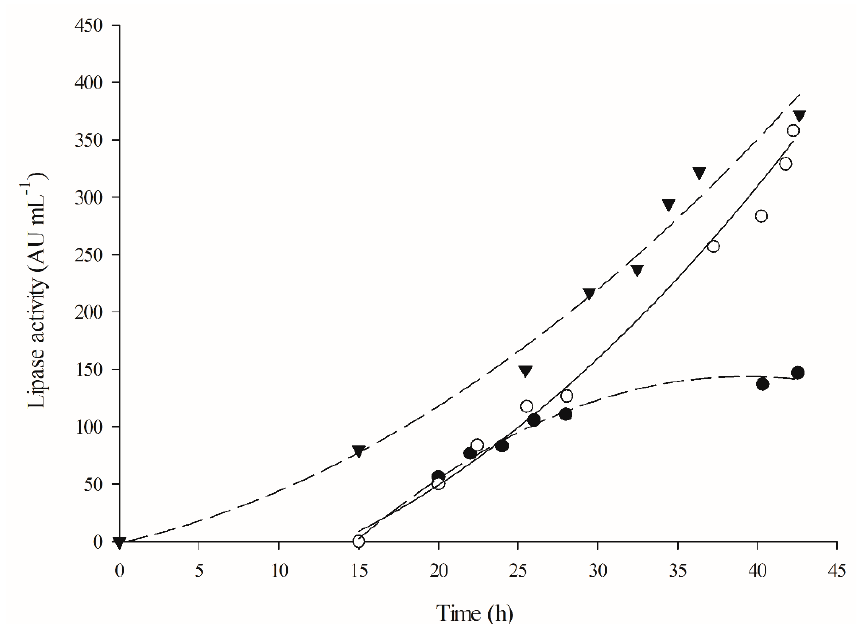
Figure 1. Time course of lipase activity in carbon limited fed-batch cultures of proROL P GAP -strain and proROL P AOX1 -strain at a preset specific growth rate of 0.045 h − 1 (dashed line) and with MNLFB (solid line). Strains: proROL P AOX1 (circles) and proROL P GAP (triangles).